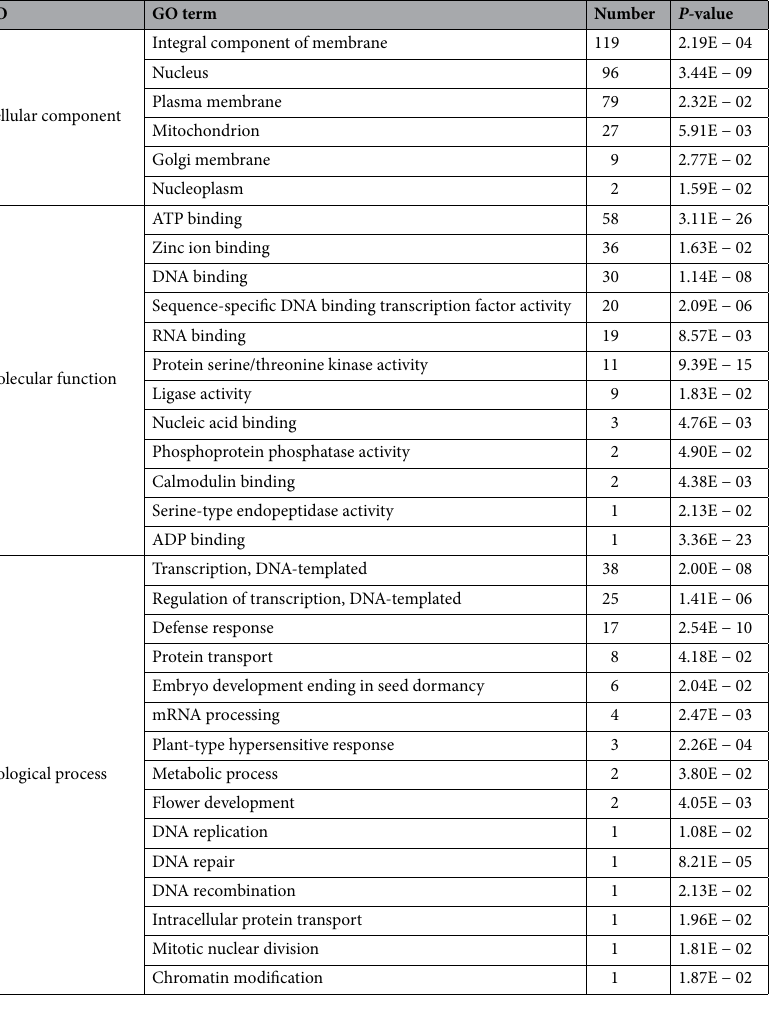
Table 4. GO function enrichment analysis of common differentially expressed genes of cultivated and wild grape